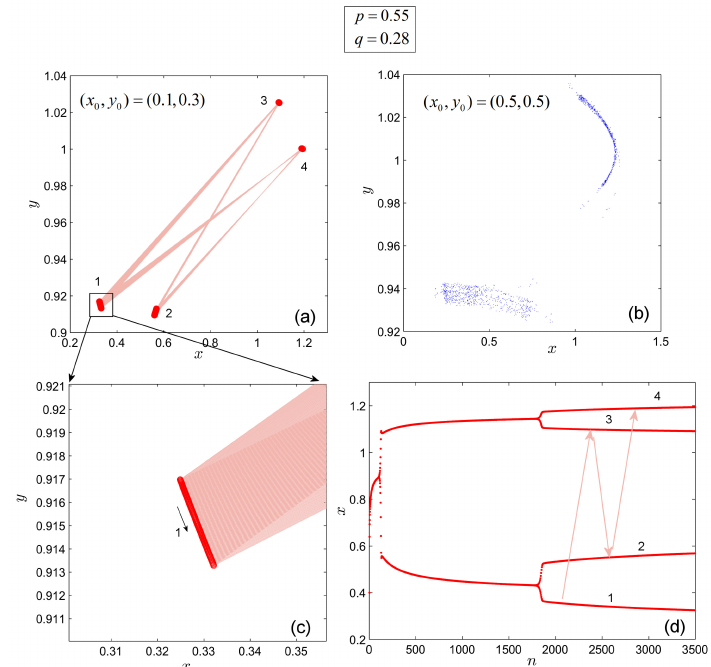
Figure 4. Two attractors for p = 0.55 and q = 0.28: ( a ) The four-periodic-like attractor for ( x 0 , y 0 ) = ( 0.1,0.3 ) ; ( b ) the two-period chaotic-like attractor for ( x the point 1 of the periodic-like orbit underlines the slow convergence of the orbit; ( d ) time series of the periodic-like